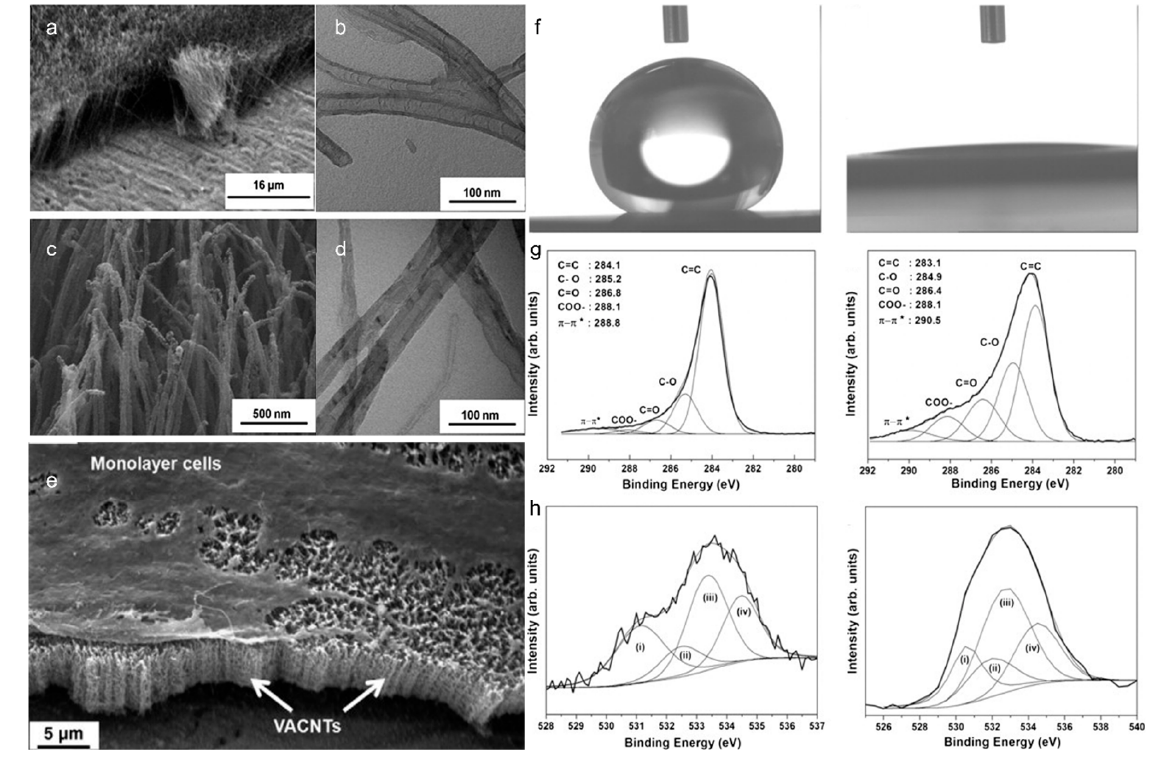
Figure 11. SEM images of ( a ) as-grown films and ( c ) superhydrophilic VACNT films; TEM images of ( b ) as-grown films and ( d ) superhydrophilic VACNT films; ( e ) characterization of human chon- drocytes on VACNT films; ( f ) change of water contact angle before and after treatment from 154° to 0°; ( g ) C1s XPS peak analysis before and after; ( h ) O1s XPS peak analysis before and after ( π - π *: The unsaturated compound transitions from the ground state ( π ) to the excited state ( π *)). [114].